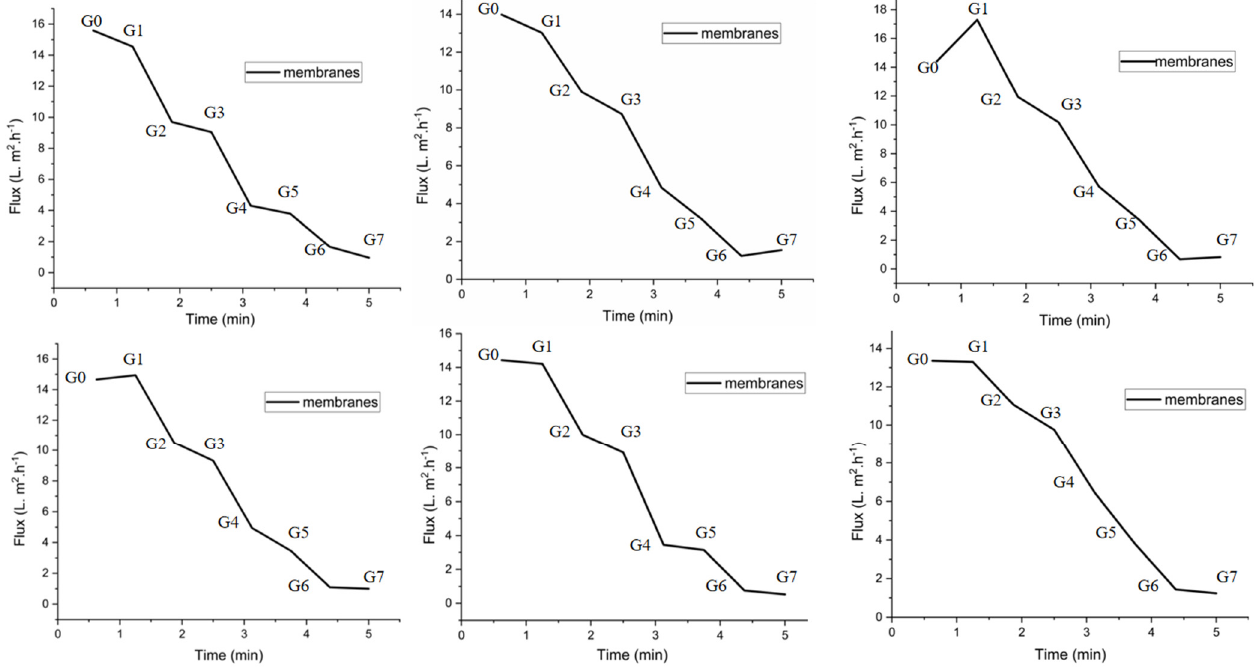
Figure 8. Measured permeation of the PES membranes (from G0 to G7) as a function of time.